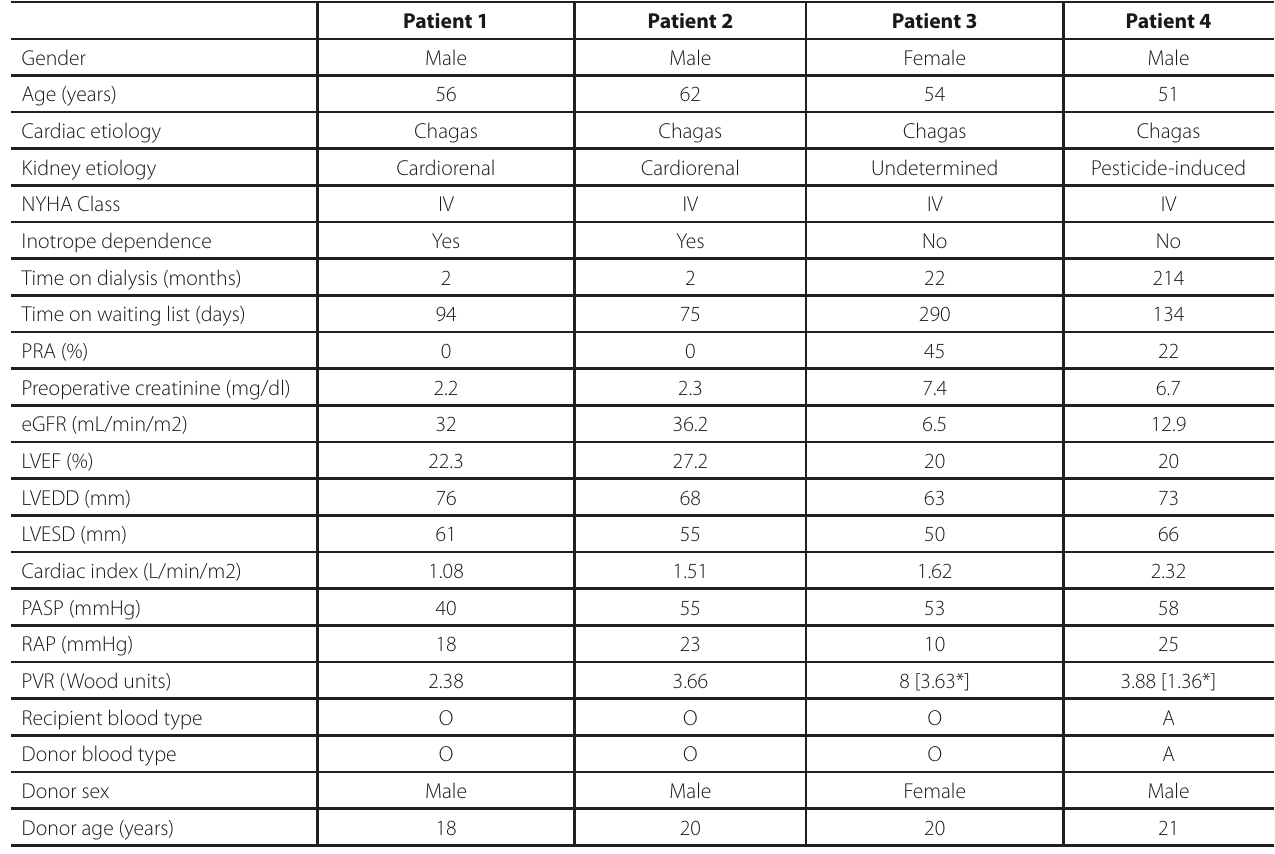
Table 1. Distribution of patient